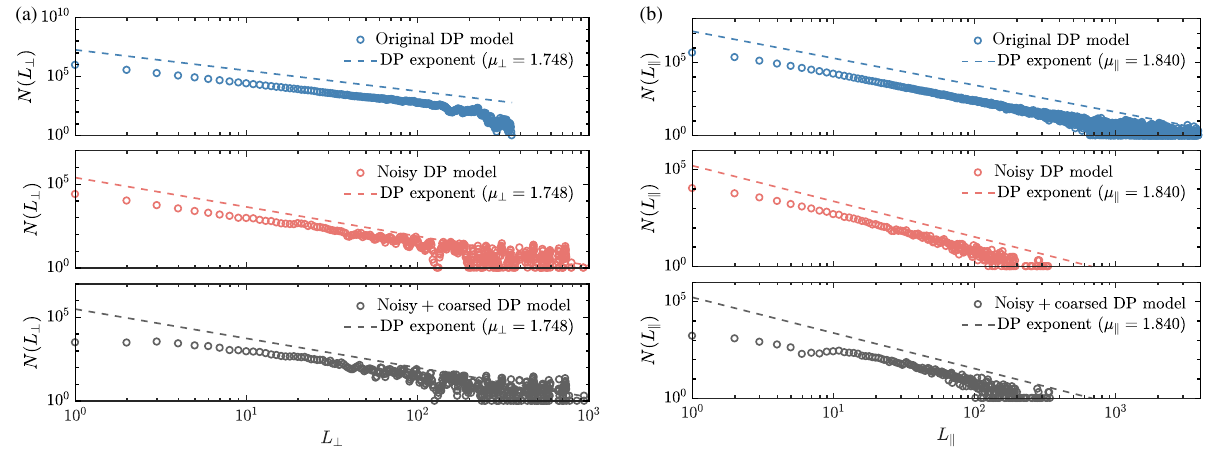
FIG. 11. (a) Size distribution of laminar clusters in space at the estimated critical value (i.e., turbulent spreading) for one illustrative binary flow field generated by applying the baseline DP model (in blue) as presented in Ref. [5]. The baseline model is then modified according to experimental constraints, allowing a fluctuating control parameter (in red) and considering metrological coarse graining (in gray). (b) The corresponding size distribution of laminar clusters in time, depicted analogously. Dashed lines show the theoretical distribution predicted by the directed percolation model at the transition. Cluster lengths are shown in multiples of the discretization used in the